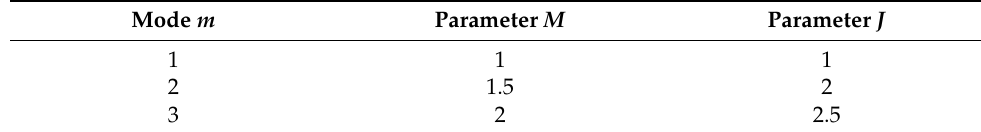
Table 2. Parameters for M and J of Different